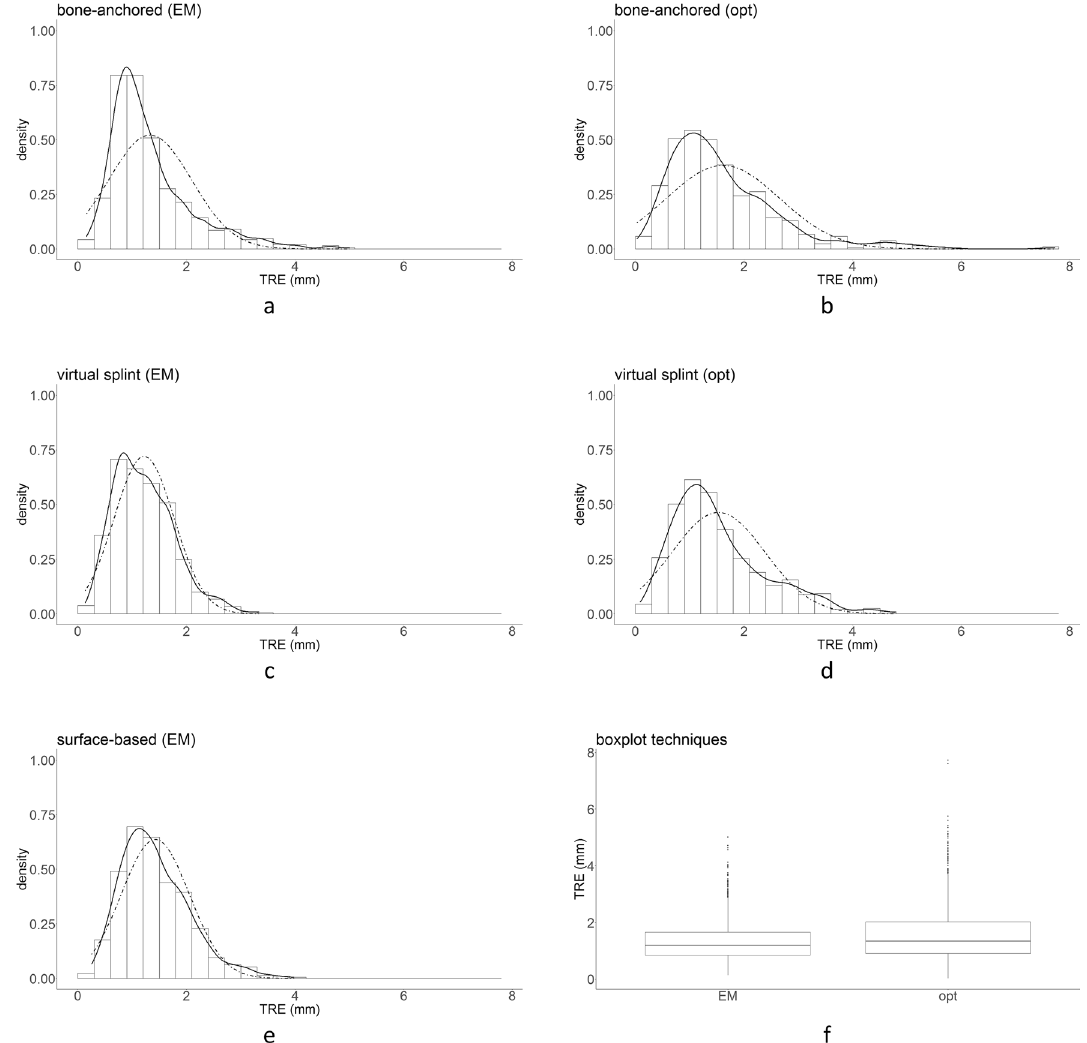
Figure 3. Distribution of TRE for each combination of tracking technique and registration method in histogram and density estimation plots ( a – e ). A normal distribution corresponding to the mean and standard deviation of the data is visualized as a dotted curve. The data is skewed to the right. In ( f ), box and whisker plots per registration technique are visualized, which point to right-skewed data as